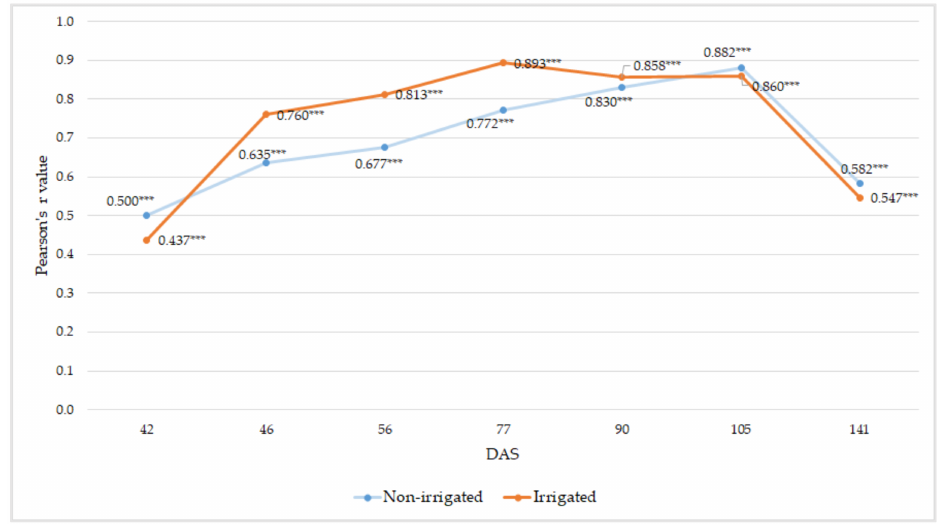
Figure 7. Pearson correlation coefficient (r) dynamics among NDVI UAV and yield t ha − 1 in non- irrigated and irrigated conditions (2021, Debrecen). Note: ***. Correlation is significant at the 0.001